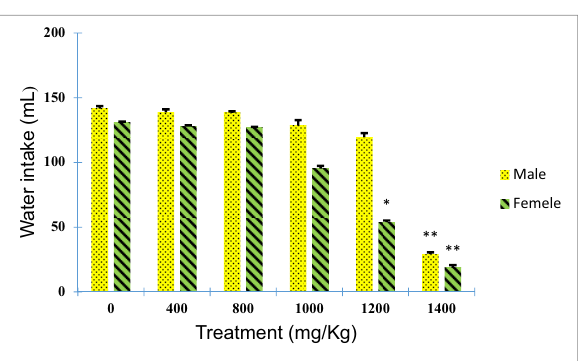
Figure 4: E ff ect of B. hispanica extracts on the bodyweight of female rats treated with a dose up to 14,000 mg/kg.